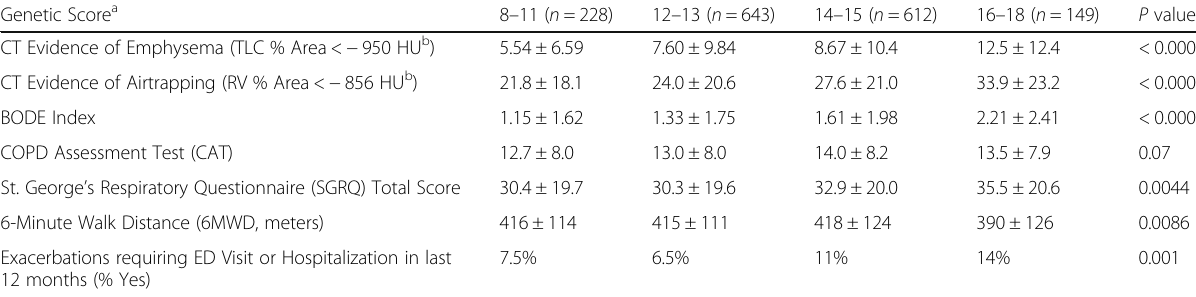
Table 5 Joint analysis of 10 SNPs with emphysema, clinical symptoms, and exacerbation Genetic Score